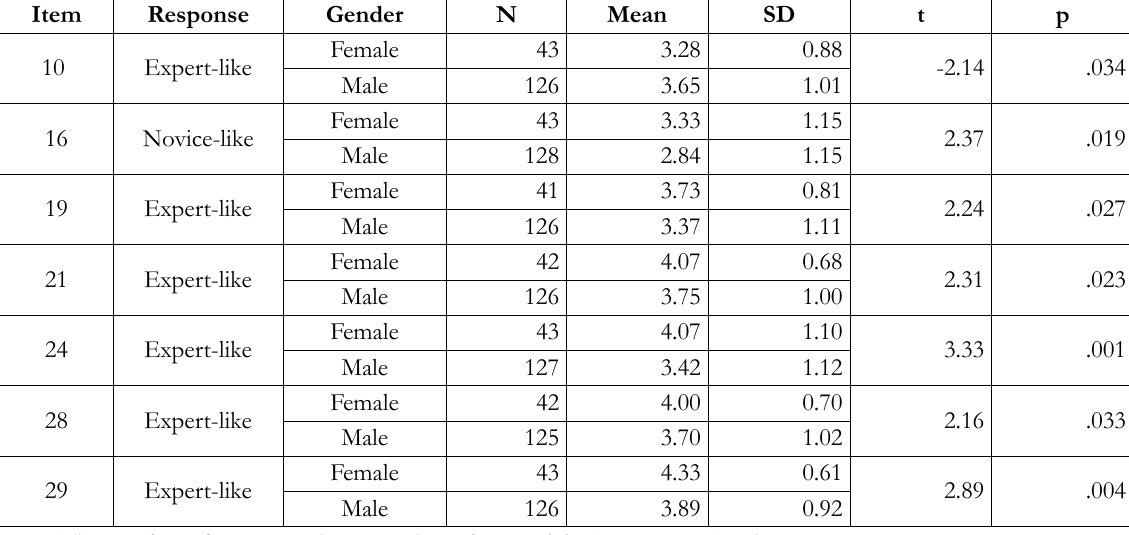
Table 1. Descriptive statistics for items that significant differences are observed between male and female students